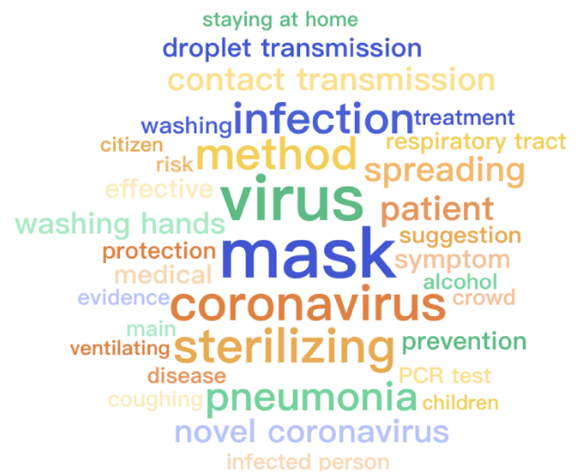
Figure 6. Word cloud of records labeled as true in the infodemic 2019 dataset.